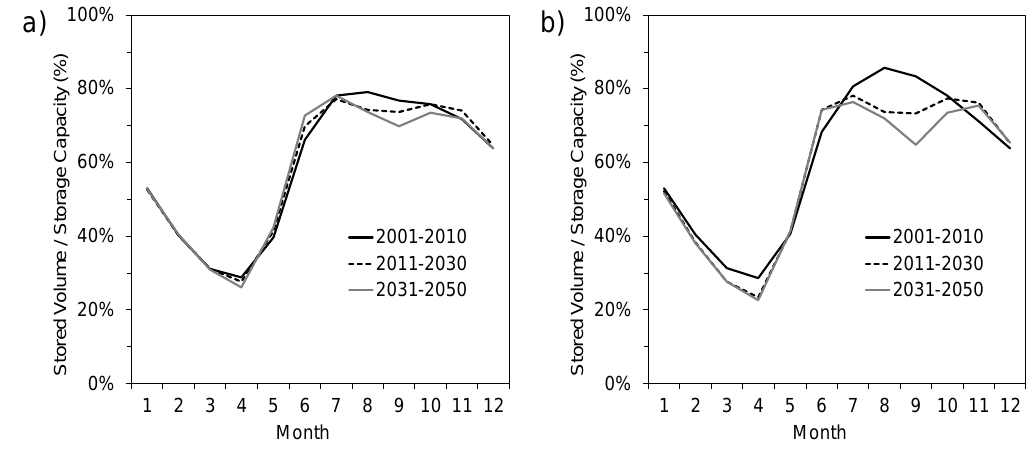
Figure 10. Average monthly stored water volume evaluated by the hydropower simulation model using the discharge dataset built starting from ( a ) REMO and ( b ) RegCM3 climatic scenarios.